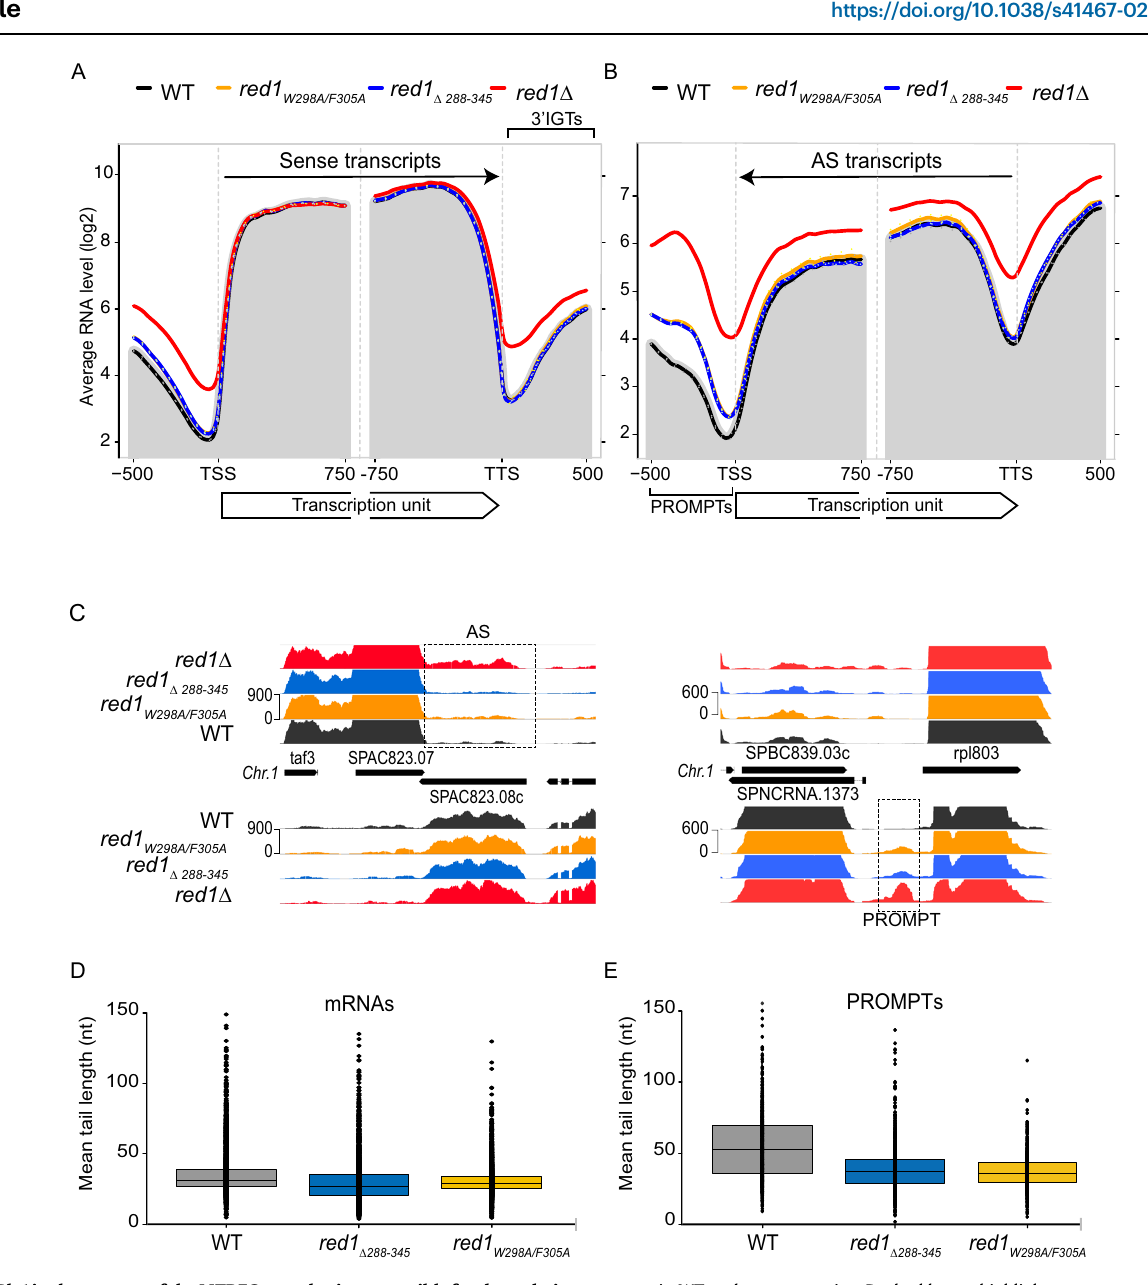
overlapping binding interface on Pla1 RRM . The inability of Iss1 to out- compete Red1 from the Pla1-Red1 complex, even though it binds only ~1.8-fold weaker compared to Red1 288-345 , prompted us to investigate the binding kinetics of the two proteins. We therefore used bio-layer interferometry (BLI) to measure possible differences in the K on / K off rates of biotinylated Red1 288-345 (Fig. 6D) or Iss1 30-76 (Fig. 6E) immobi- lised on streptavidin-coated biosensors to Pla1 FL . Compared to